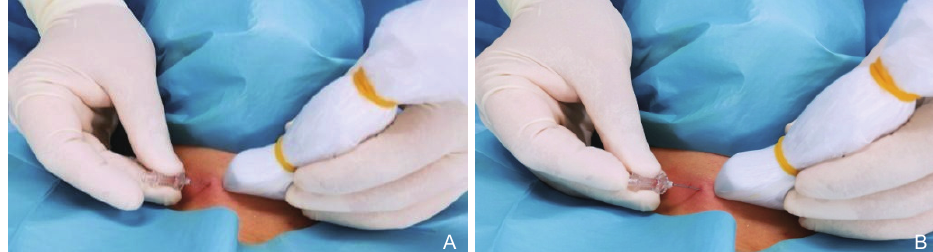
Figure 14 Non-suction aspiration method of FNA. (A) Inserting the needle, the needle holder inlet is not blocked, so that the air in the needle cavity can be discharged, then the specimen can enter the needle cavity; (B) Lifting the needle, the index finger of the operator blocks the inlet of the needle holder, which can isolate the needle cavity from the outside and generate a negative pressure inside, then the specimen can be sucked into the needle